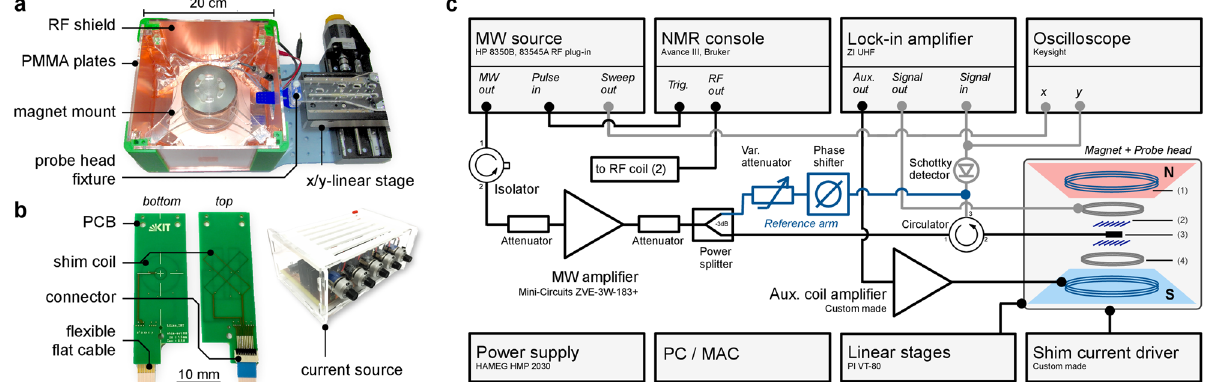
Figure 5. ( a ) The 0.5 T permanent magnet is suspended inside an RF-shielded box for environmental isolation. For precise positioning at the magnet’s most uniform spot, the probe was mounted on a motorised x/y linear stage. ( b ) Top and bottom of the fabricated PCB-based, five channel, bi-planar shim coils as well as the custom made shim current driver. ( c ) Schematic of the ODNP measurement setup. The reference arm (blue) as well as the one-port reflectometry setup (gray) are optional and were not permanently connected. The magnet + probe head panel includes, (1) B 0 -field coil of permanent magnet, (2) RF coil, (3) MW resonator and (4) EPR modulation coil. Figure used with permission 41